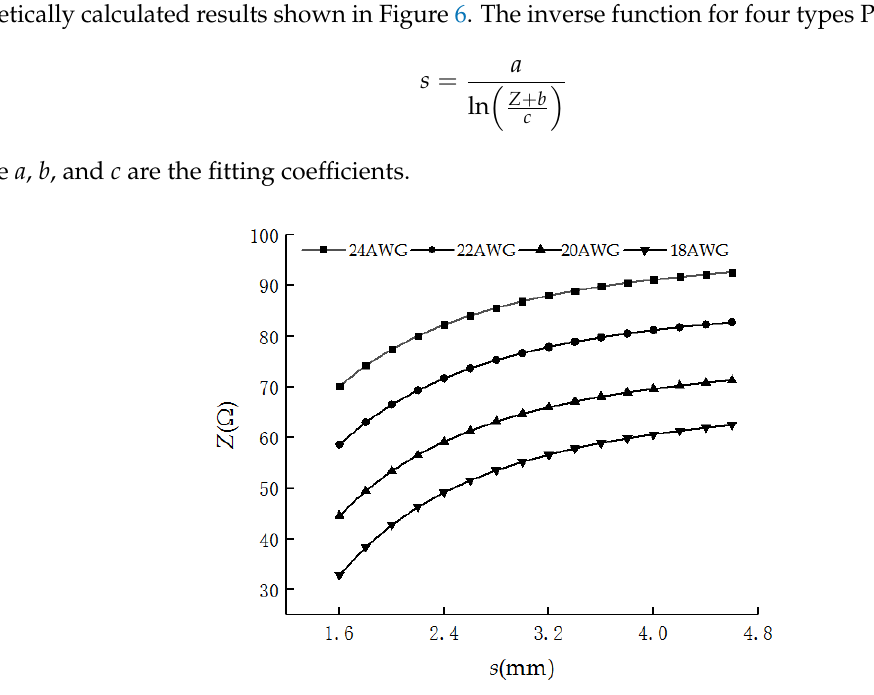
Figure 6. The calculated characteristic impedance Z of the four types of PHSC.